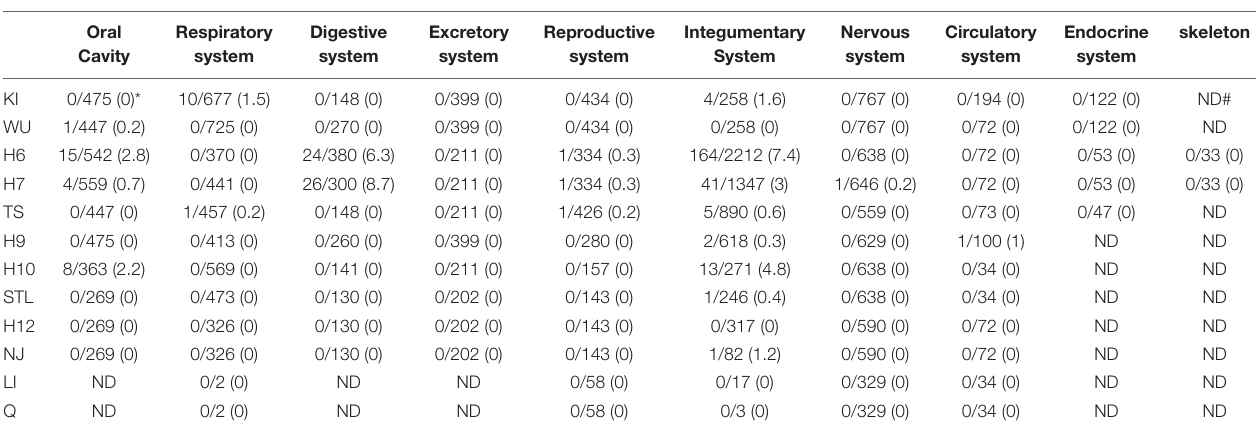
FIGURE 4 | Amino acid sequence of MT-ag, ALT, sT-ag and LT-ag of TSPyV. The common sequences are enlightened in the same color. Putative functional motifs are shown. TABLE 1 | Prevalence of novel HPyV in human tumor